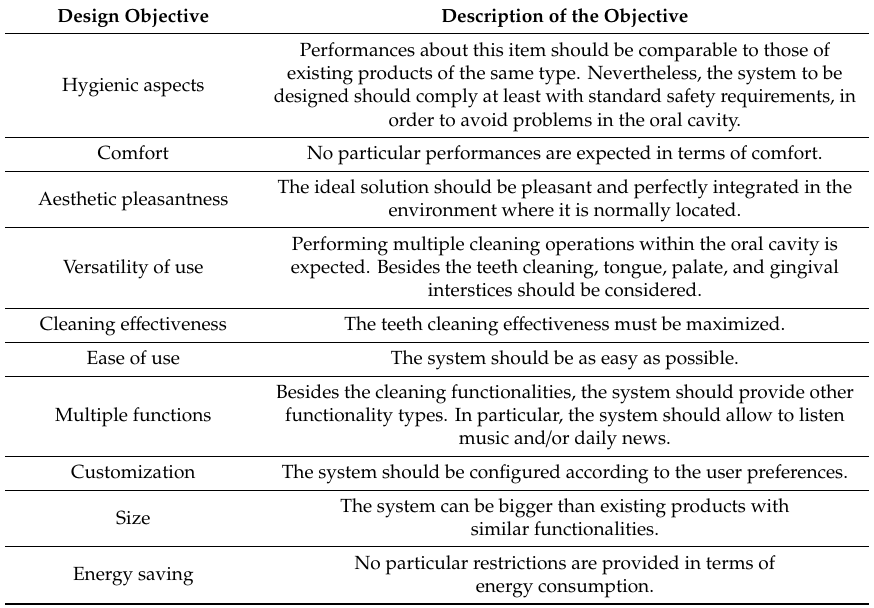
Table 2. Initial information provided to the subjects in terms of target goals for the product.